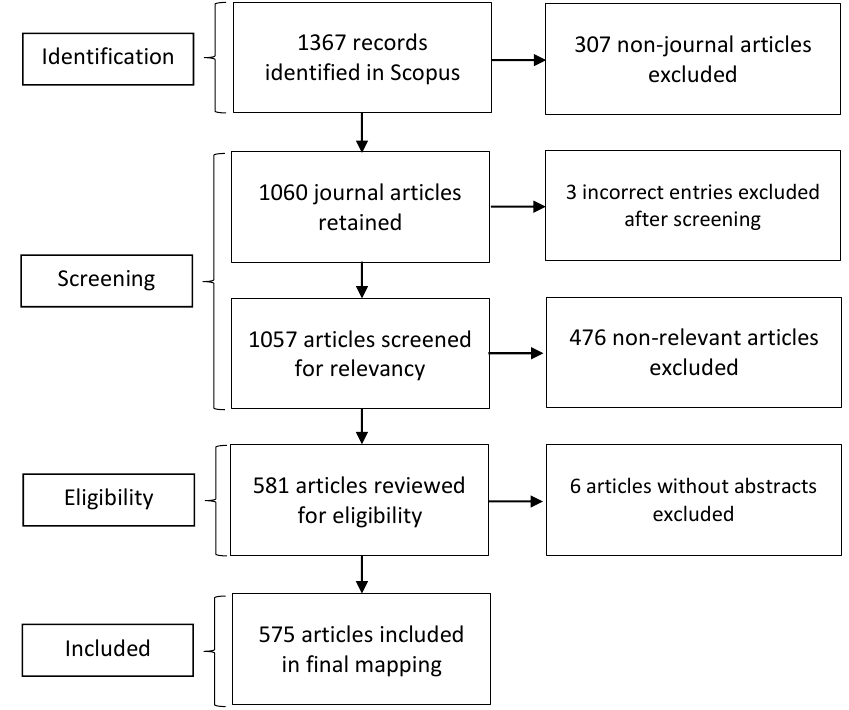
Figure 2. PRISMA diagram of corpus on access to geriatric disability care.